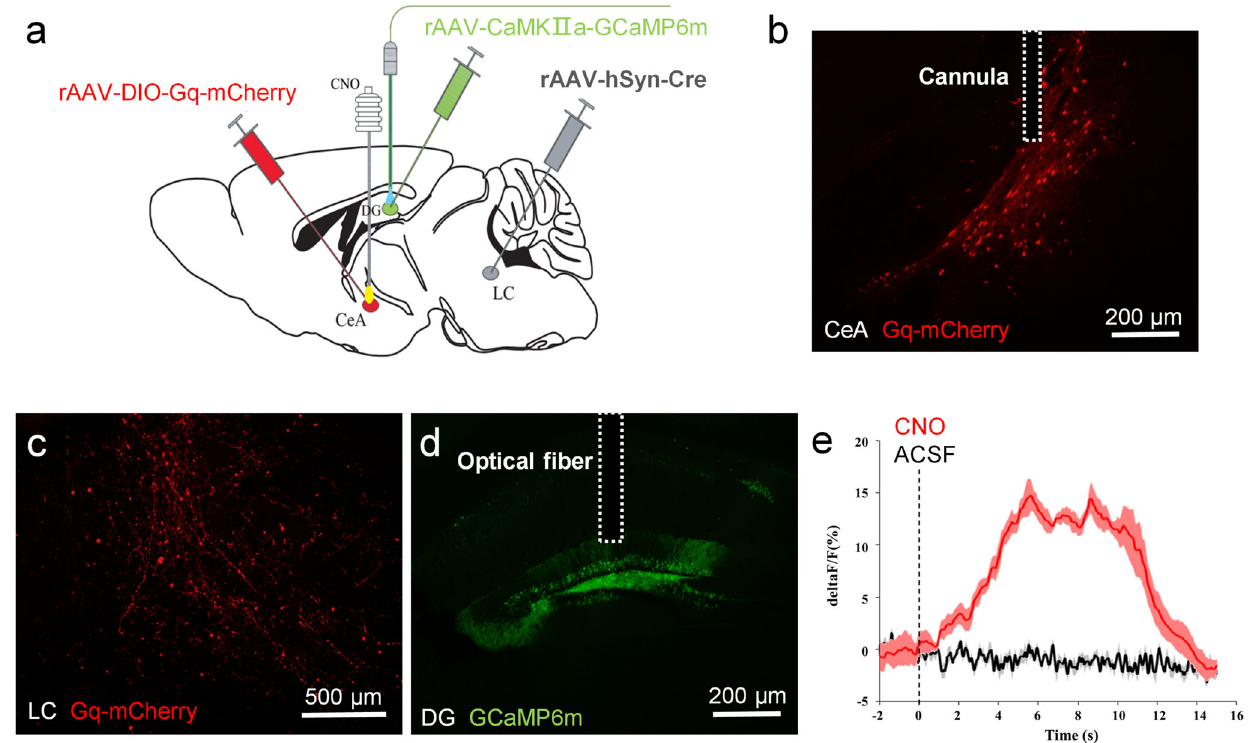
Fig. 7 Chemogenetic activation of the CeA neurons increased the activity of CaMKII α + neurons in the DG. a Schematic illustration of the experimental setup for the functional examination of the CeA-LC-DG circuit. The AAV-DIO-Gq-mCherry virus was injected into the CeA, and a cannula for intra-CeA injection of CNO or saline was embedded above the injection site. The retrograde virus AAV-hSyn-Cre was injected into the LC. The AAV-CaMKII α - GCaMP6m virus was injected into the DG, and an optical fi ber was embedded above the injection site for calcium imaging. b Intra-CeA injection of the AAV-DIO-Gq-mCherry virus induced the expression of Gq-mCherry (red) in the CeA. The dotted lines represent the embedded cannula. c Gq-mCherry (red) is also expressed at the terminals of CeA-LC projection neurons in the LC. d Intra-DG injection of the AAV-CaMKII α -GCaMP6m virus-induced restricted expression of GCaMP6m in CaMKII α + neurons in the DG. The dotted lines represent the embedded optical fi ber. e The calcium signal in the DG was increased after an intra-CeA injection of CNO, but not ACSF ( n = 5).